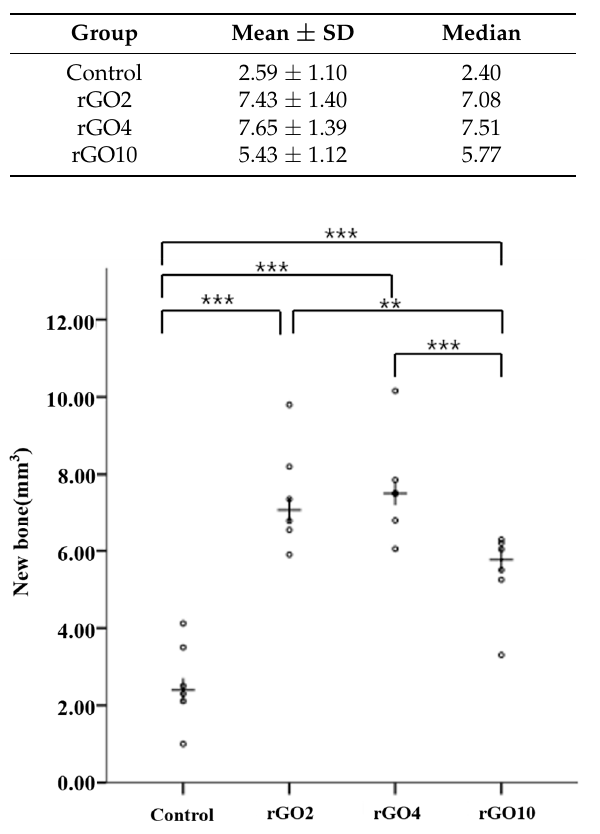
Figure 5. Micro-computed tomographic images. ( A ) Control group; ( B ) rGO2 group; ( C ) rGO4 group; ( D ) rGO10 group. Table 1. New bone volumes within regions of interest ( n = 6; mm 3 ).